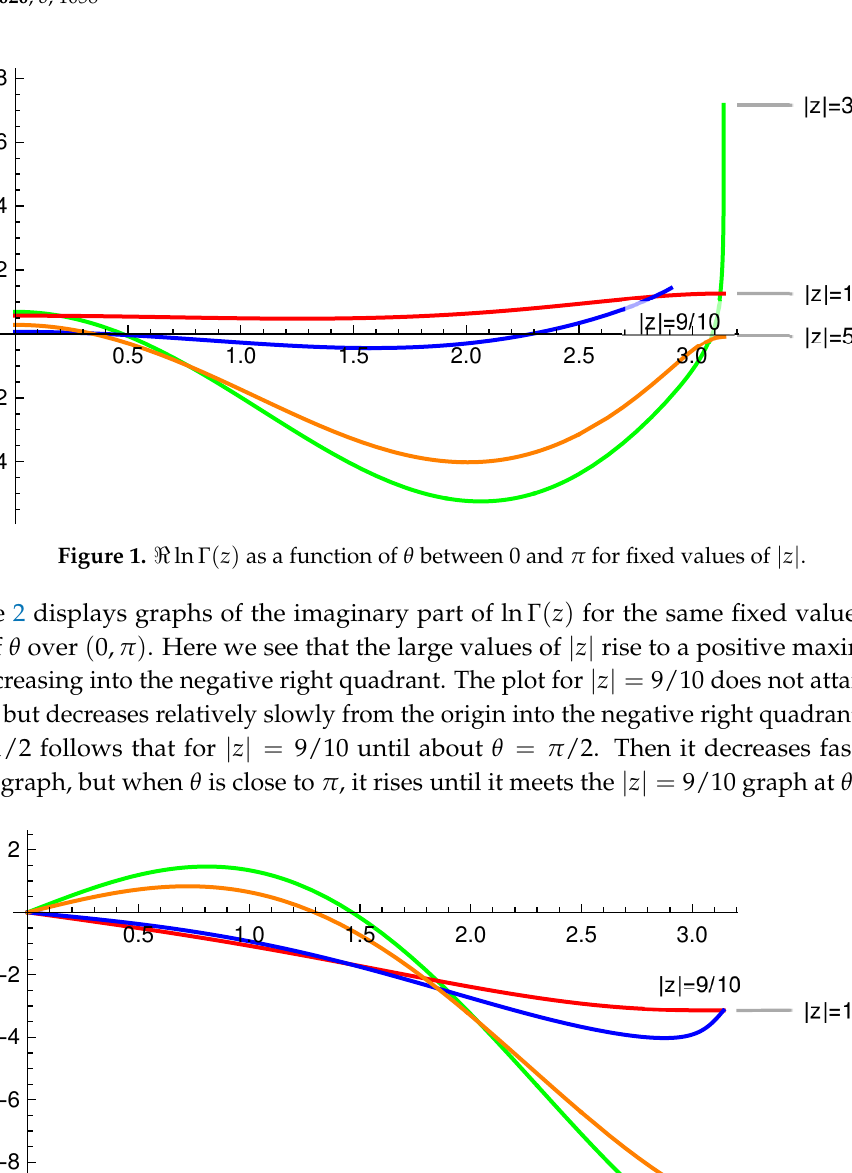
Figure 2. ln Γ ( z ) as a function of θ between 0 and π for fixed values of (cid:61)